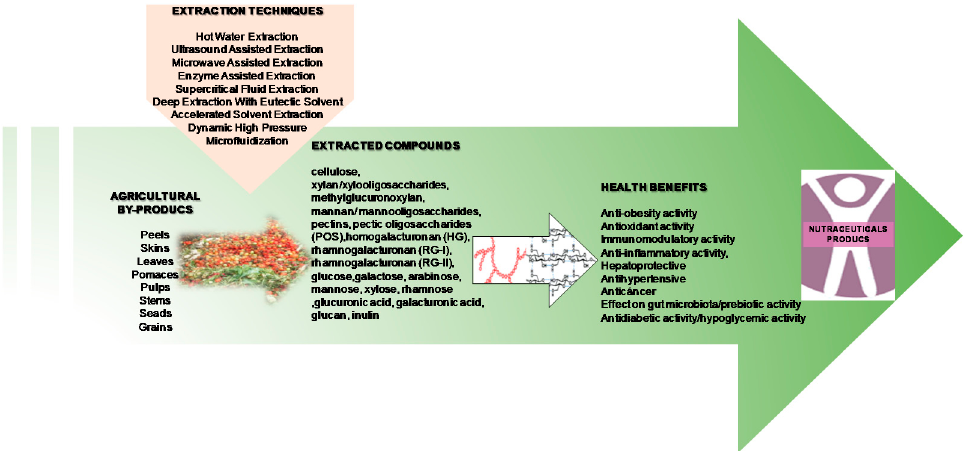
Figure 1. Overview of extraction of agricultural waste by-product polysaccharides with different health-beneficial activity for nutraceutical use.